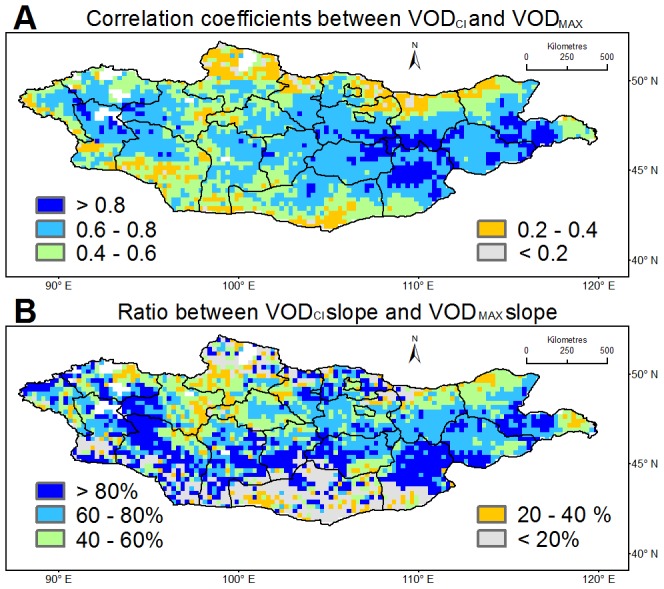
Relationship between VODCI and VODMAX.(A) Correlation coefficients (r2) between VODCI and satellite-based VODMAX during 1988–2008. (B) Ratio (%) between the slope of VODCI and the slope of satellite-based VODMAX for the period 1988–2008.